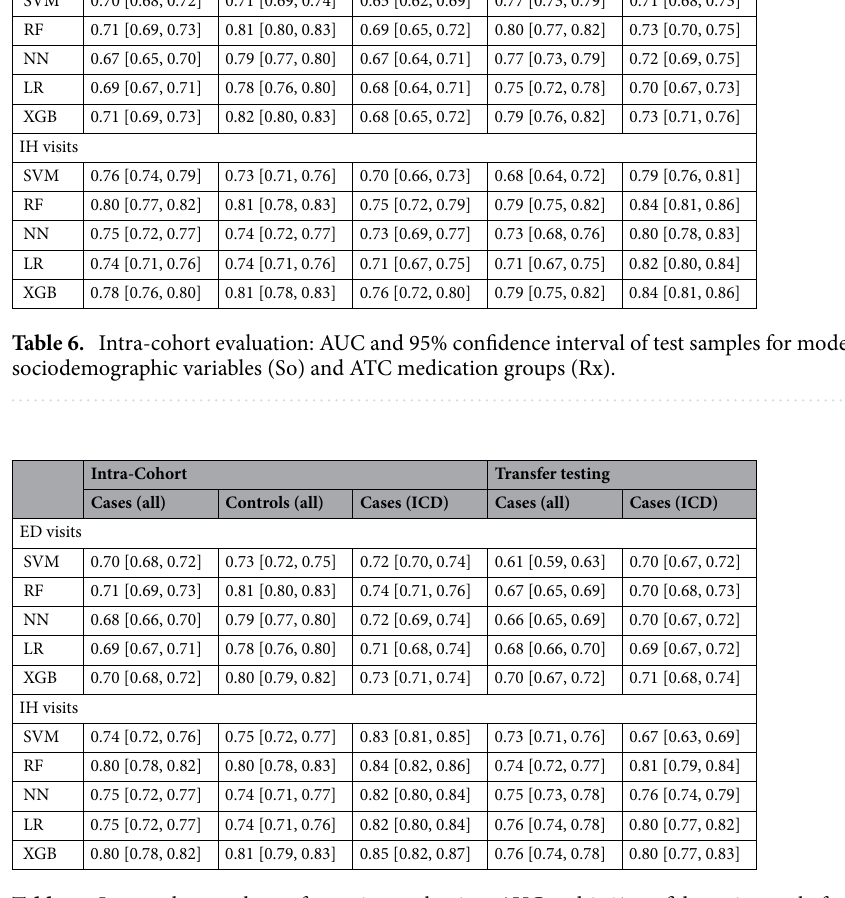
Table 7. Intra-cohort and transfer testing evaluation: AUC and 95% confidence interval of test samples for models using sociodemographic (So), Elixhauser comorbidity conditions (Dx) and ATC medication groups (Rx)